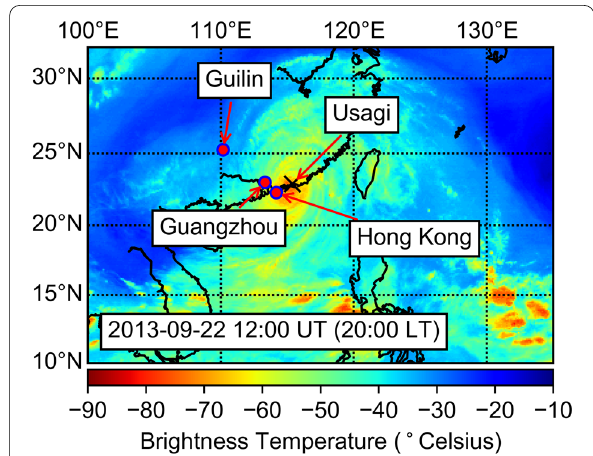
Fig. 2 Location (black cross mark) of the 2013 TC Usagi at 12:00 UT (20:00 LT) on 22 September 2013, and the locations (red dots) of Hong Kong, Guangzhou, and Guilin. The background color represents brightness temperature (Celsius) extracted from the Himawari 7 images